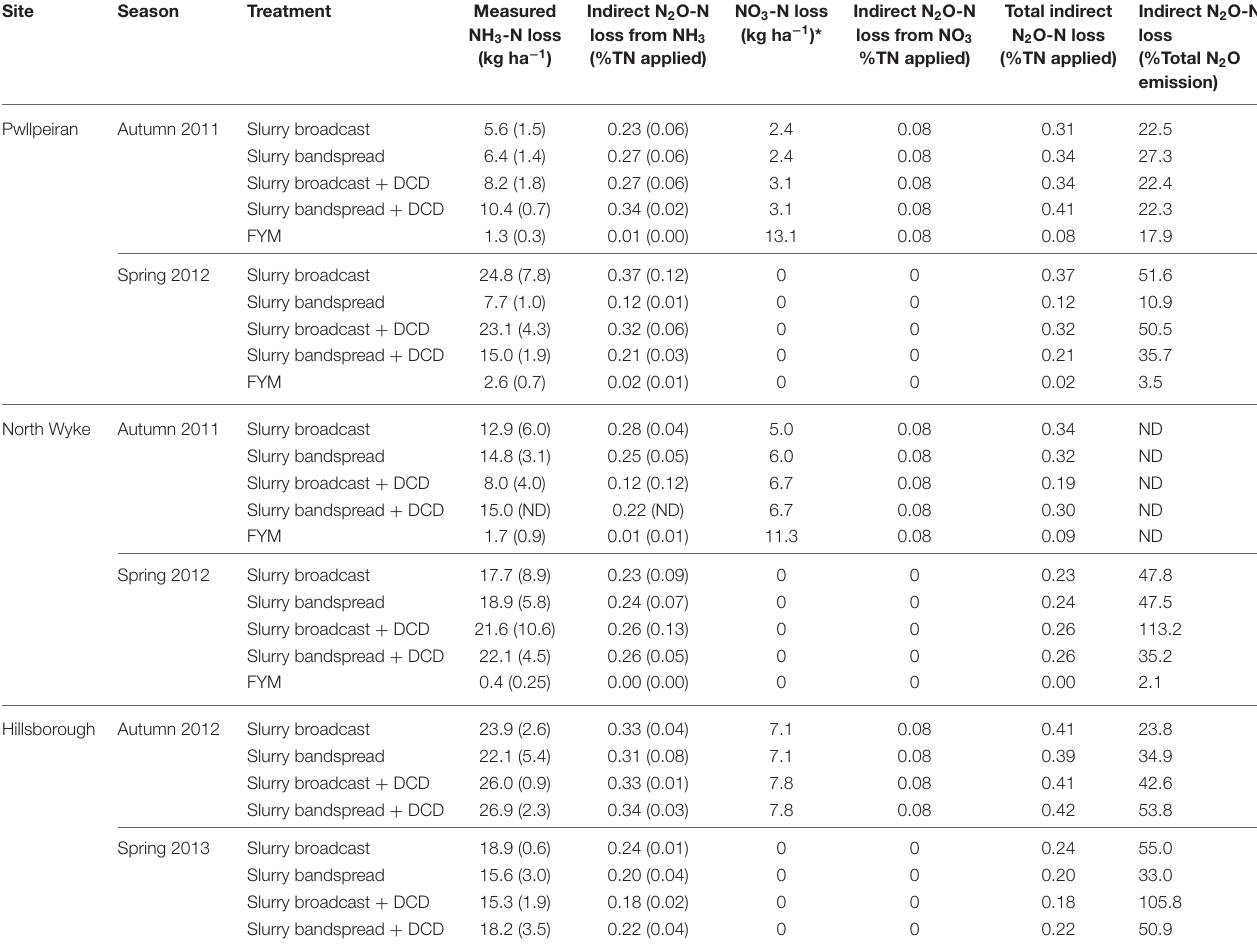
TABLE 6 | Mean NH 3 volatilization and NO 3 leaching losses, and calculated indirect N 2 O emissions at the grassland sites.